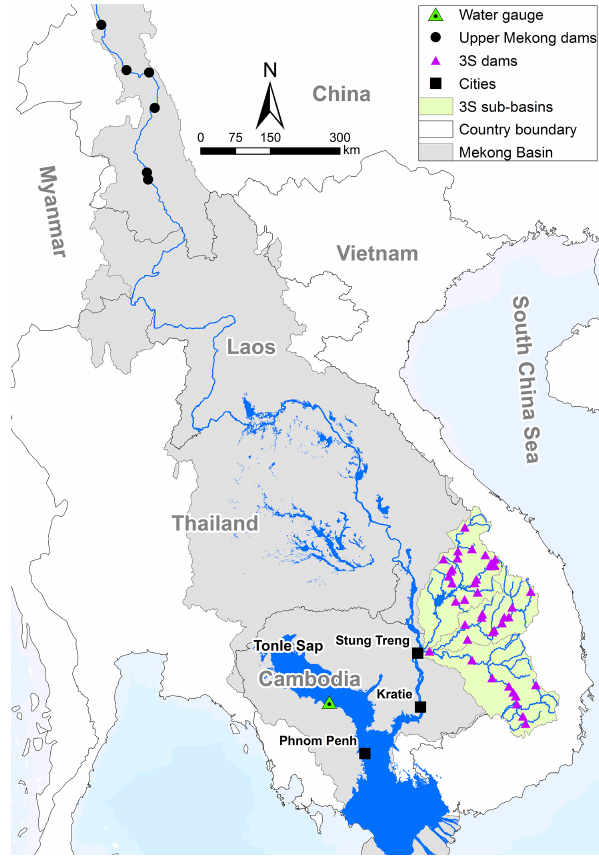
Figure 1. Map of the Mekong Basin highlighting its floodplains and dams in the definite future (black dots) and 3S development scenarios (violet triangles). The green triangle shows the Kampong Luong water level gauge location on the Tonle